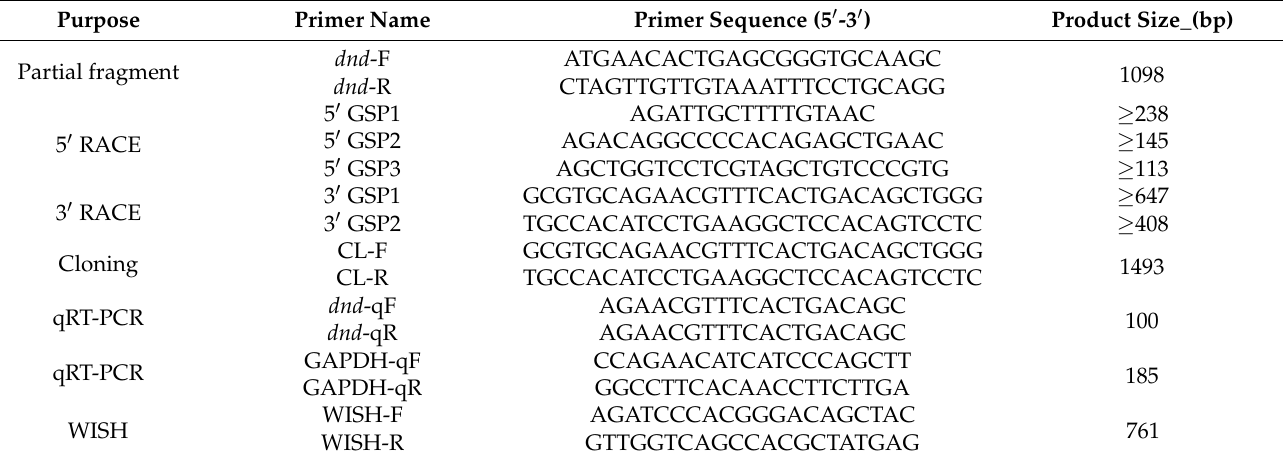
Table 1. Primer and probe sequences for psdnd cloning and